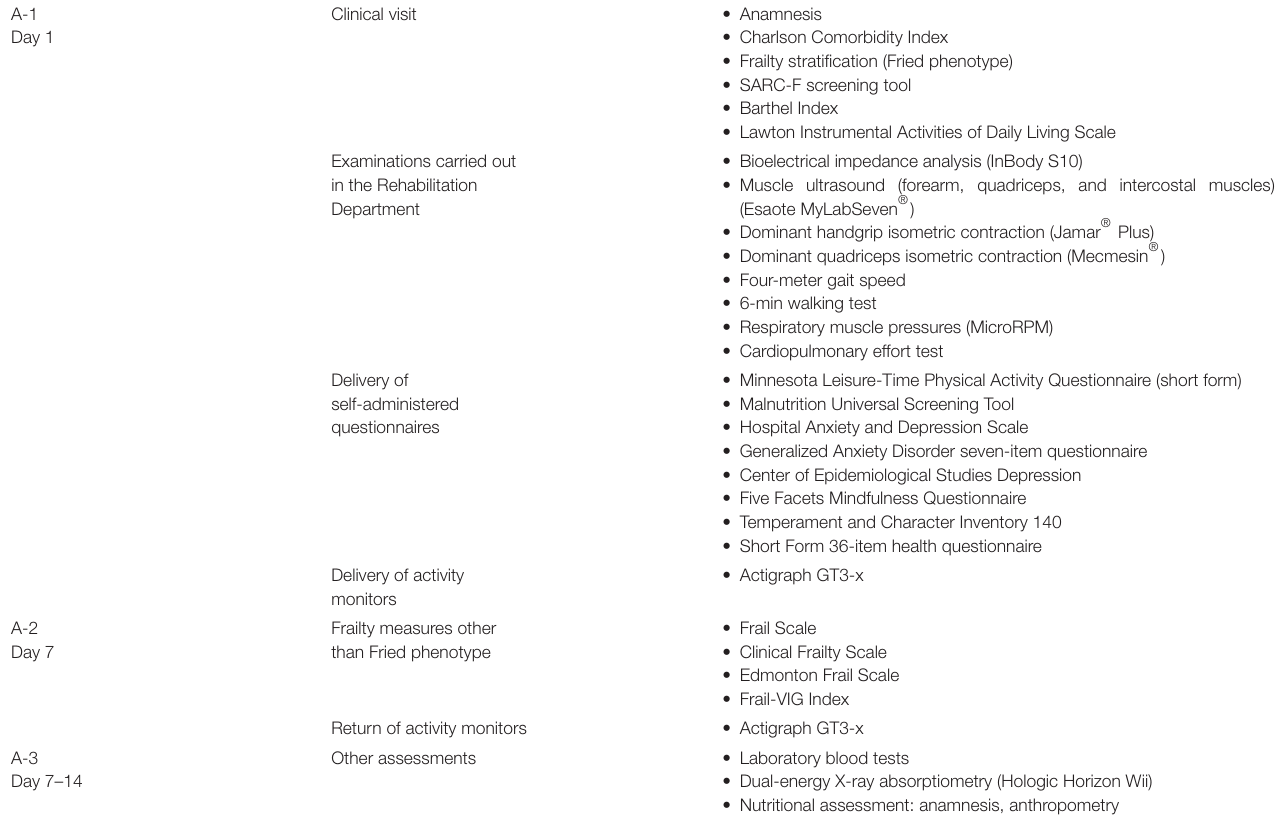
TABLE 2 | Baseline assessment: sequence of examinations and delivery of